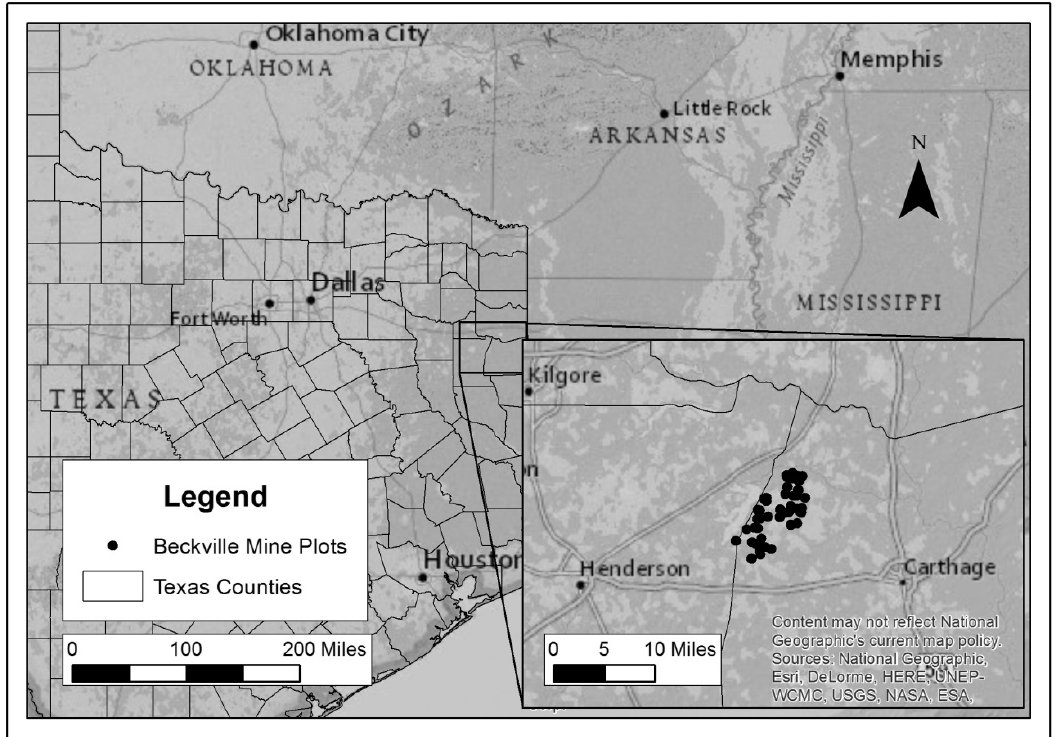
Figure 1. Plot locations on Luminant’s Beckville Mine in east